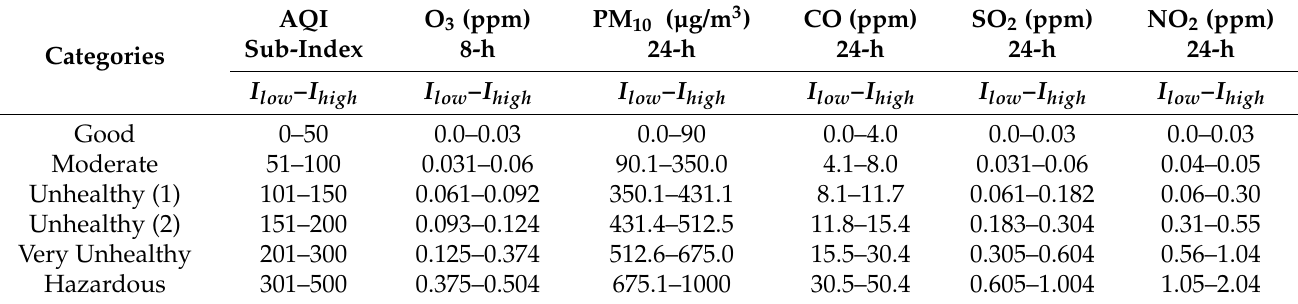
Table 1. Kuwait Air Quality